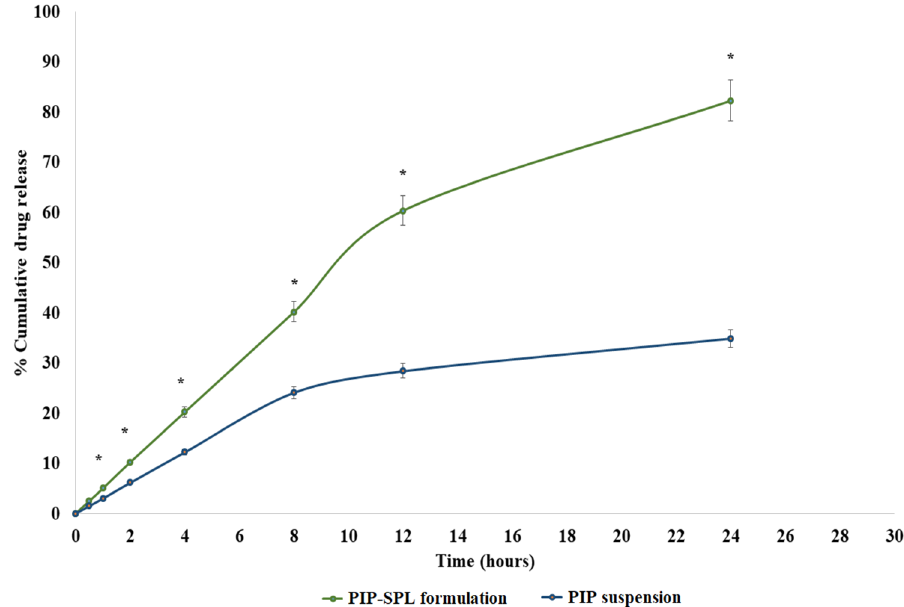
Figure 4. Comparative in vitro drug release profile of PIP suspension and PIP-SPLopt formulation. *: statistically significant at p ≤ 0.05.